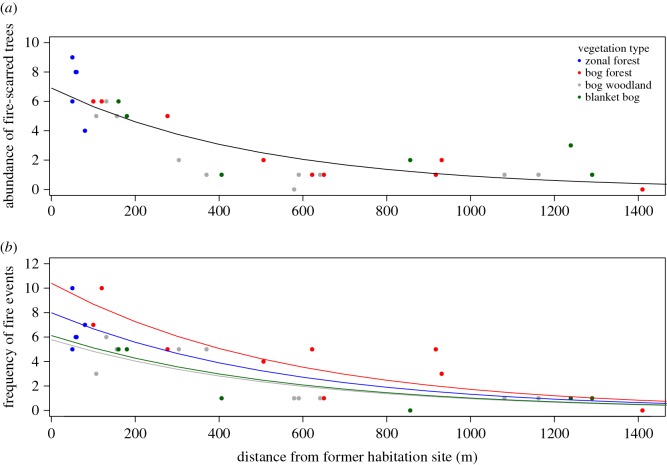
(a) Poisson regression of the relationship between the abundance of fire-scarred trees and the distance from habitation sites in metres. The most parsimonious model related the presence of fire scars to distance from habitation sites only, and model averaging indicated that the distance to habitation sites was significantly (p < 0.01) more influential than any other predictor or combination of predictor variables. (b) Poisson regression of the relationship between the frequency (number) of fire events in each vegetation type and the distance from habitation sites in metres. The most parsimonious model includes three variables (distance to habitation site, aspect and bog forest vegetation type), and distance to habitation site was the most important predictor variable (p < 0.001).